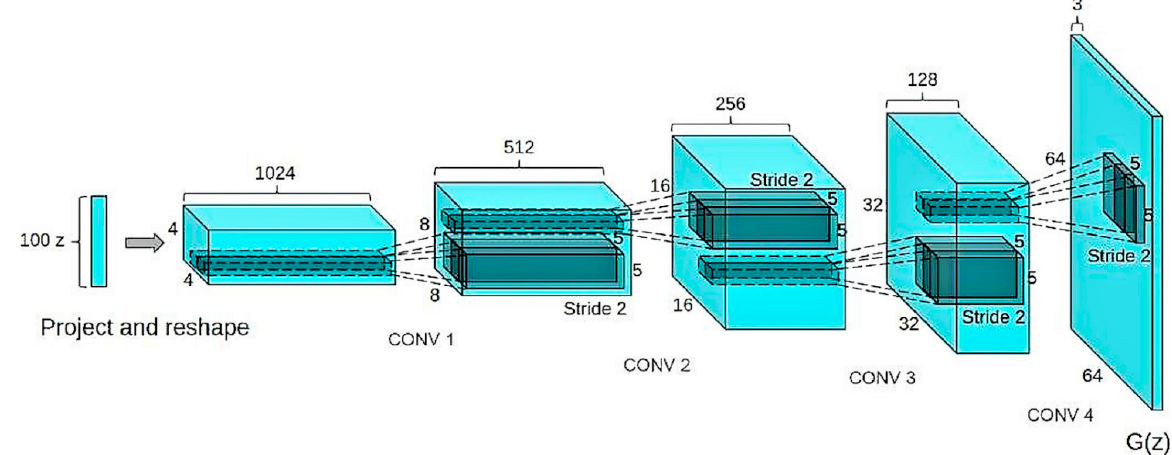
Figure 6. Generator for the large-scale scene understanding (LSUN) bedroom dataset DCGAN that uses fractional convolutional layers (deconvolutional layers) to generate images from a 100-dimension noisy distribution.